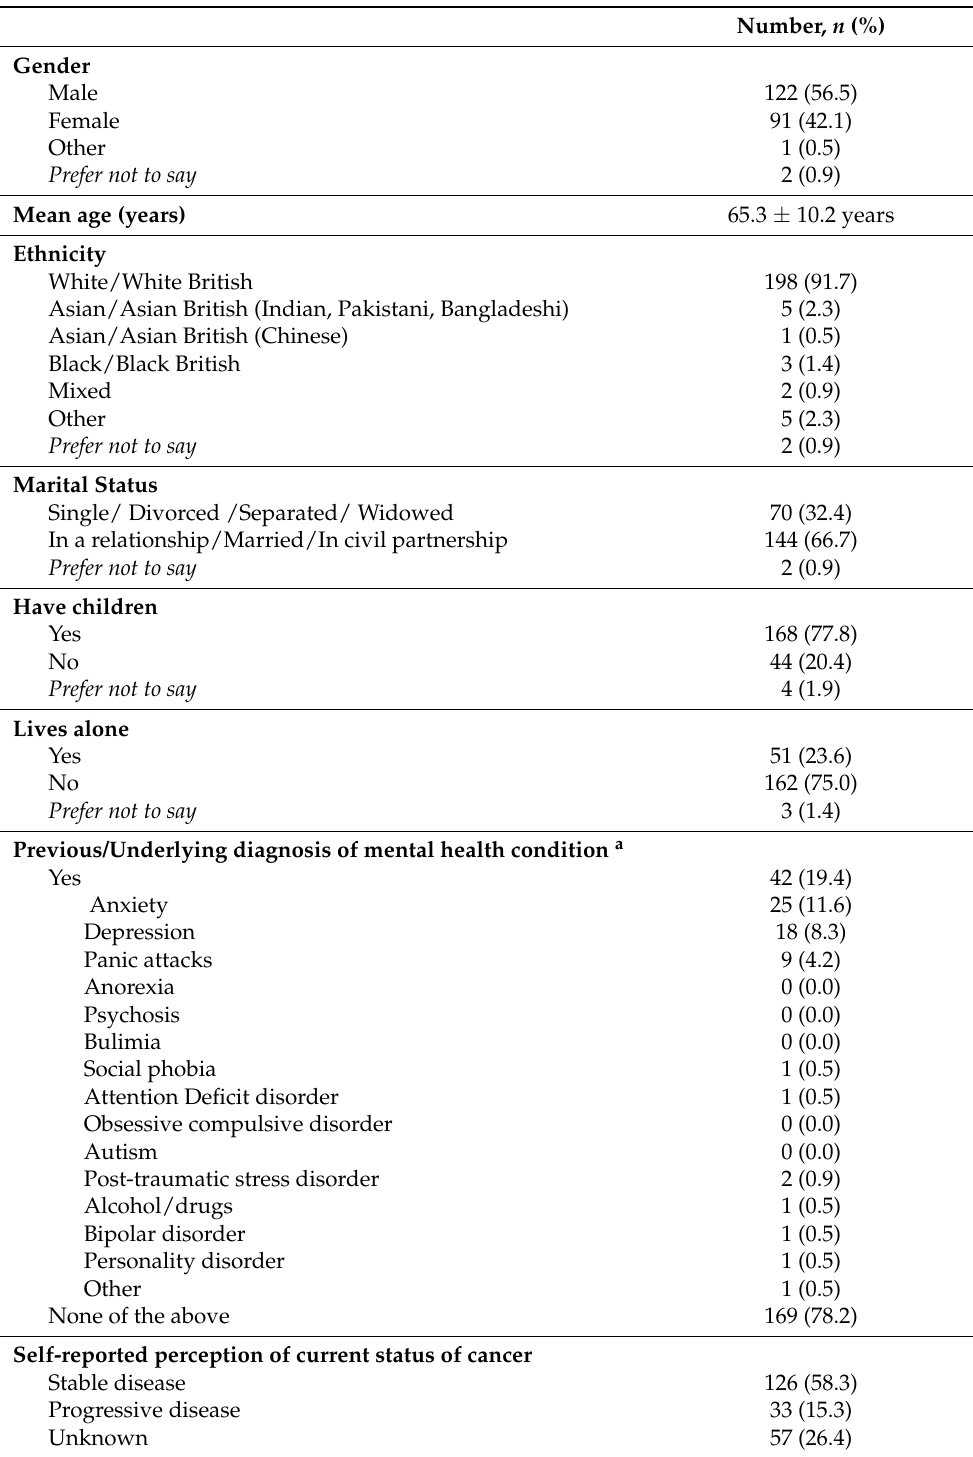
Table 1. Baseline demographics of participants in the PICO-SM study ( n =